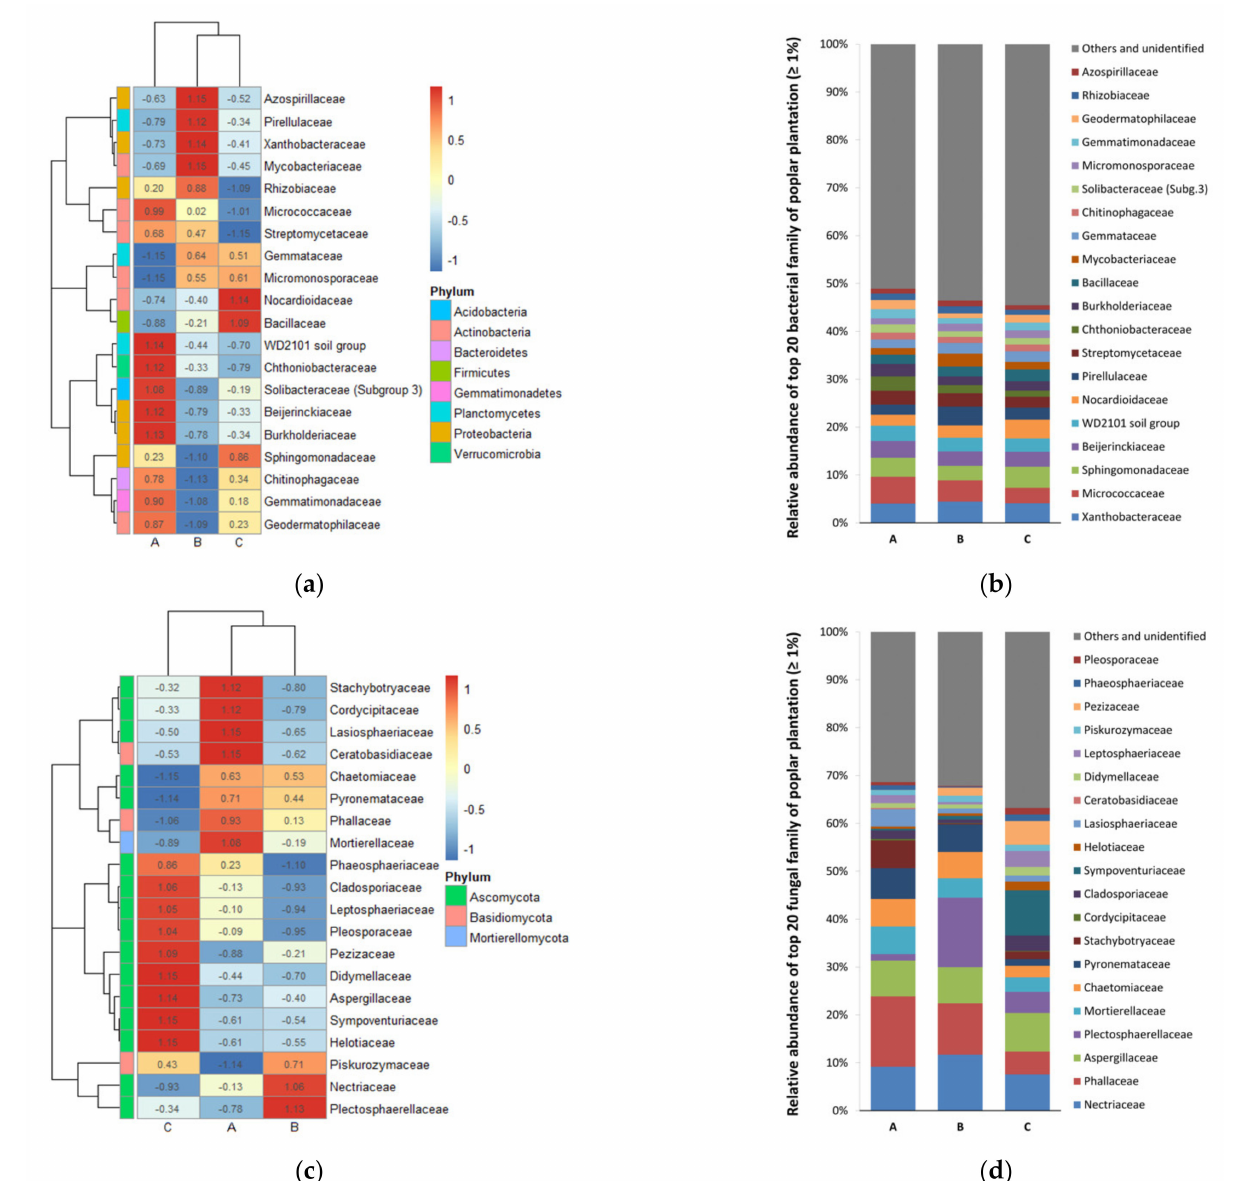
Figure 6. Relative abundance by the corresponding z-score of the top 20 bacterial ( a ) and fungal ( c ) families; relative abundance (%) of top 20 bacterial ( b ) and fungal ( d ) families in rhizosphere soil of poplar plantation by treatments; control (A), fertilizer (B) and ectomycorrhizal (C)